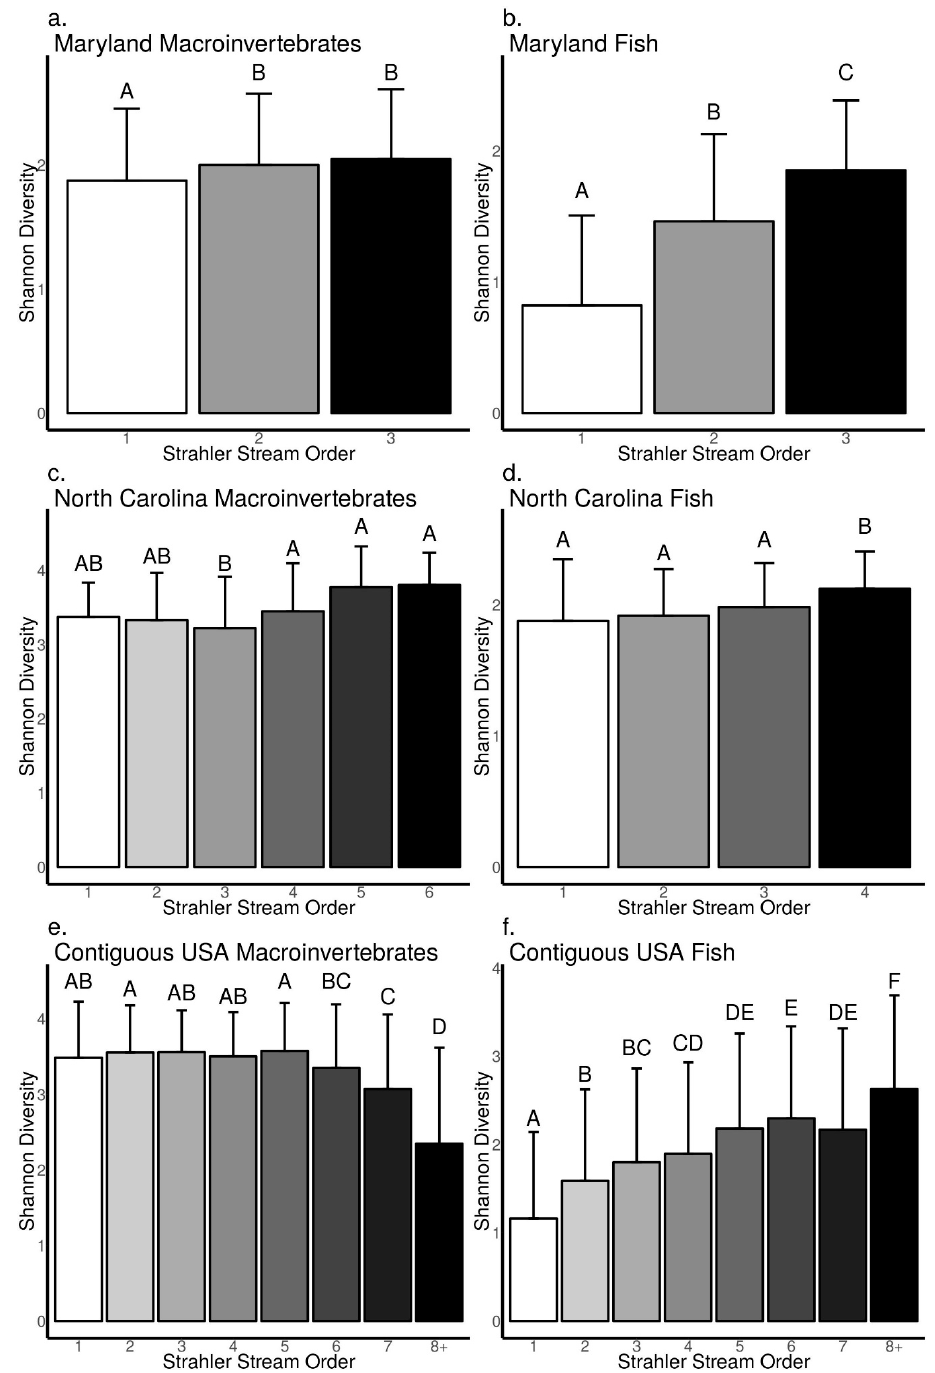
Figure 5. Relationship between Shannon diversity and Strahler stream order for macroinvertebrate ( a , c , e ) and fish ( b , d , f ) communities collected from Maryland (MBSS), North Carolina (NCBMP) and contiguous USA (USEPA). Error bars represent standard deviation and different letters indicate significant differences between orders determined using Tukey’s HSD multiple comparisons .